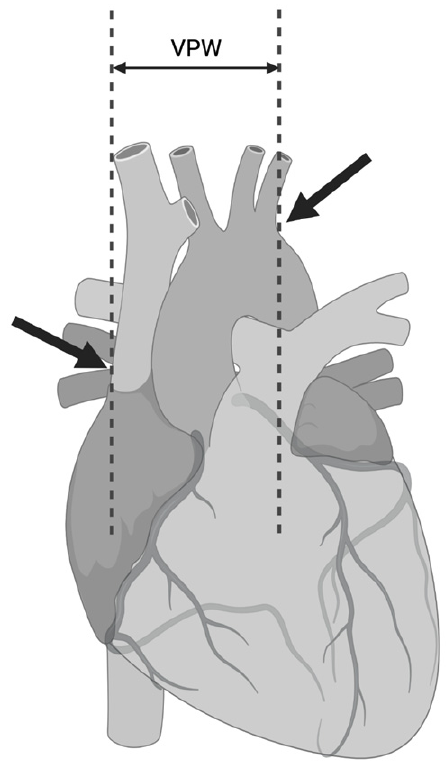
Figure 2. Vascular pedicle width. (Created with BioRender.com).